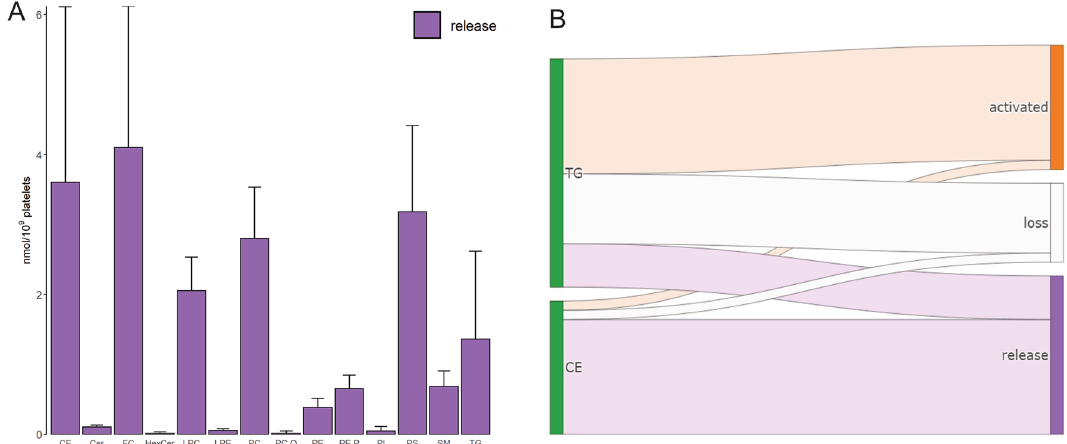
Figure 3. Lipid species release. Displayed are ( A ) sum concentrations of lipid classes of lipid release upon thrombin stimulation. Mean and SD of 12 healthy human donors. ( B ) Sankey diagram showing the lipid flow of neutral lipids triglycerides (TG) and cholesteryl ester (CE) upon platelet activation (mean concentration n = 12).